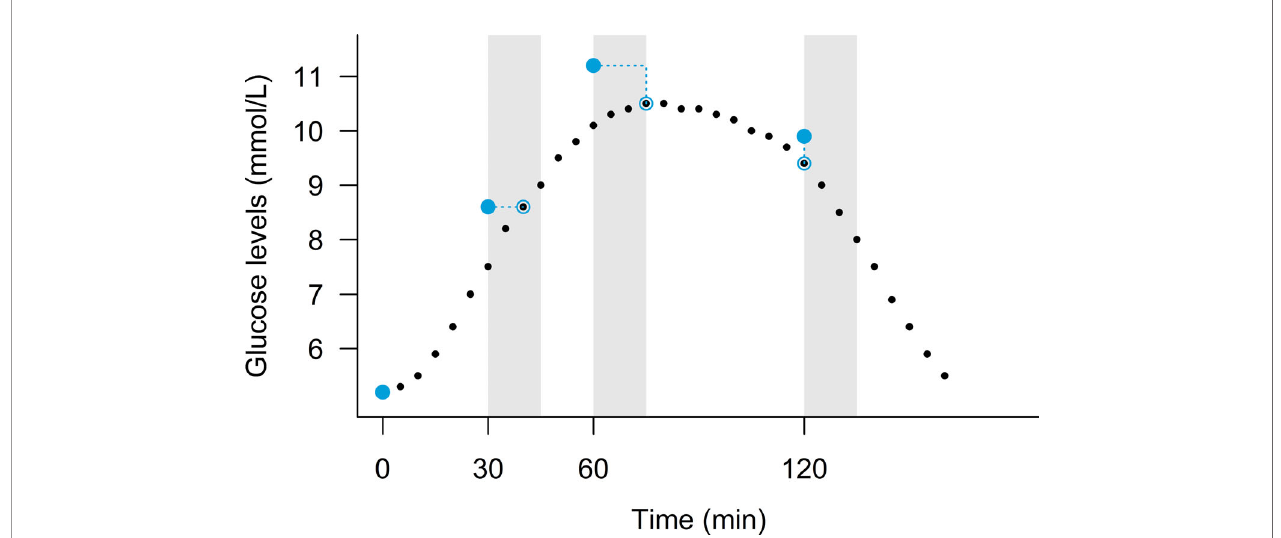
FIGURE 1 | An example of (plasma glucose levels) measured during the OGTT (large blue points) and simultaneously by the continuous glucose monitoring device (black points) in a person. The light grey areas indicate the 0-15 min period after the OGTT measurements, and the dotted blue lines point to the best CGM match within the 15 min